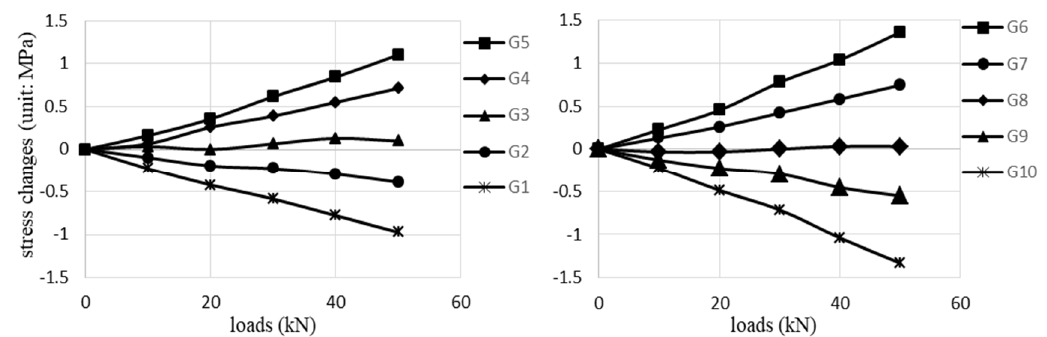
Figure 9. The values of stress changes measured by the strain gauge G1 ∼ G10.